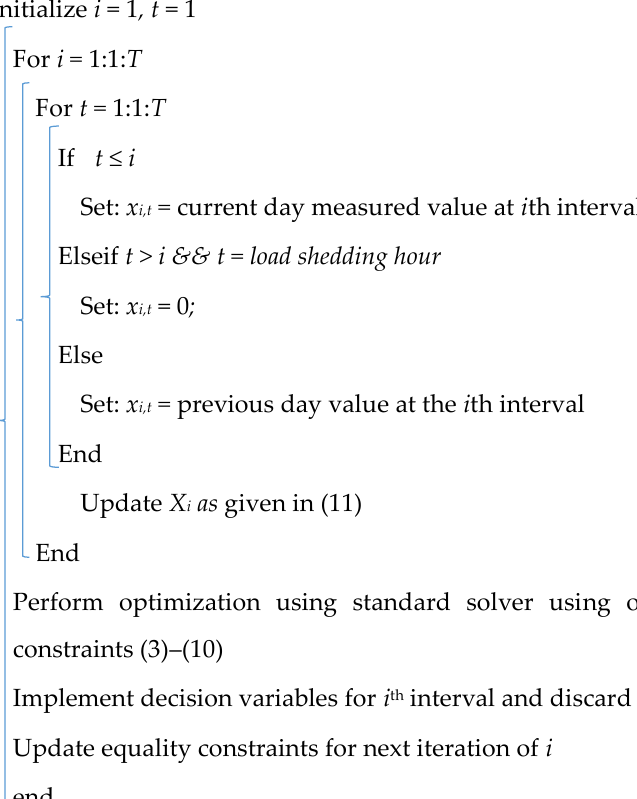
Algorithm 1: Algorithm for the online optimization